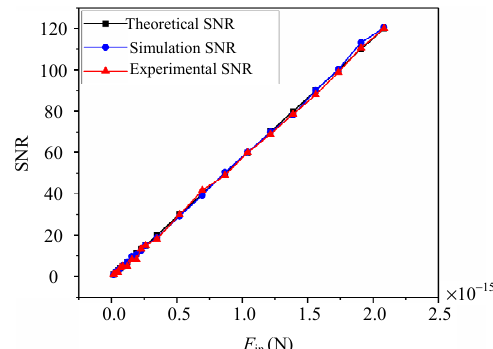
Fig. 7 Relationship between SNR and